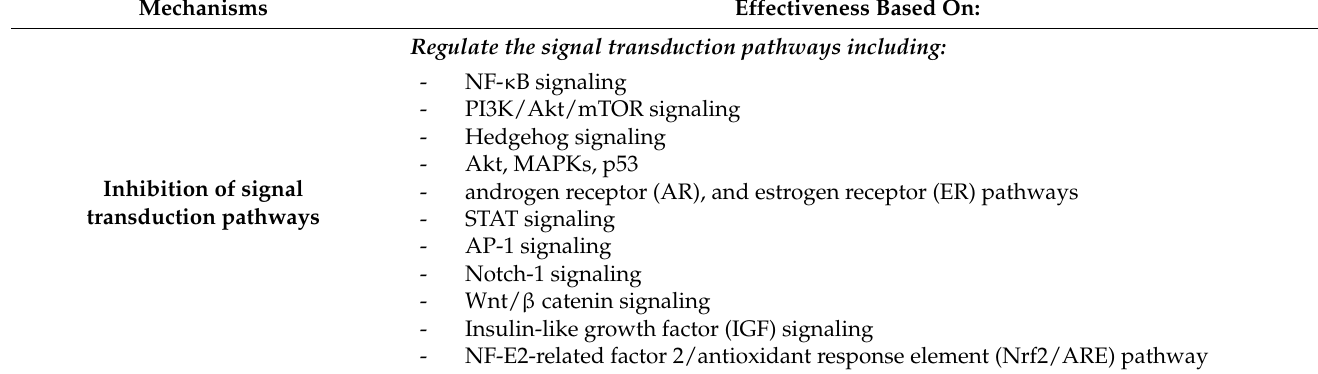
Table 3. Cont. Mechanisms Effectiveness Based